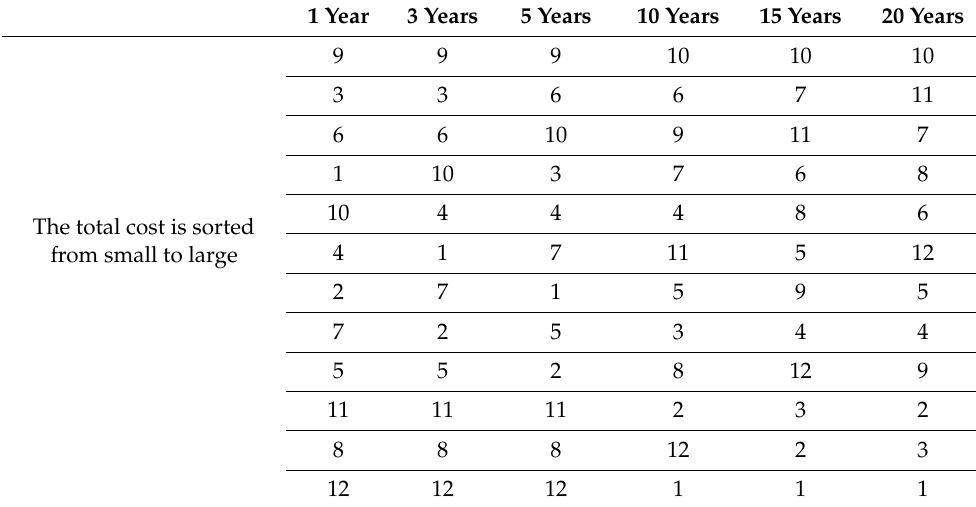
Table 5. The total cost of 12 types of lines running for different